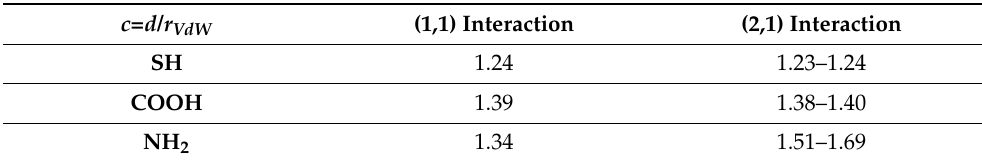
Table 3. Coefficients associated with the binding capabilities of the different functional groups here investigated (SH, COOH, NH 2 ) in the cysteine molecule and for the (1,1) and (2,1) interaction with